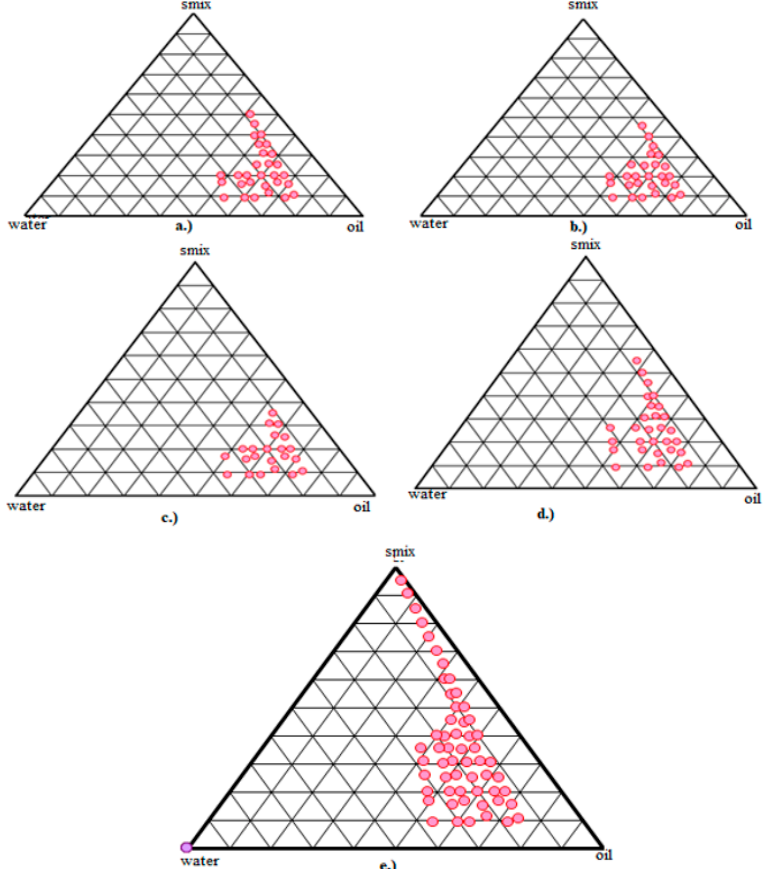
Figure 1. Pseudo-ternary phase diagrams showing different Smix ratios of the surfactant/cosurfactant ratio, ( a ) 1:1; ( b ) 1:2; ( c ) 2:1; ( d ) 4:1; ( e ) 5:1, of the nanoemulsion, which is composed of Tween 20 (surfactant), Transcutol HP (cosurfactant), eucalyptus oil as oil phase, and water (q.s).